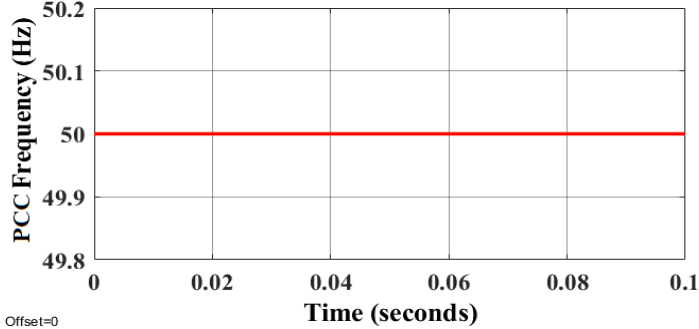
Figure 13. AC common bus frequency using the proposed technique.